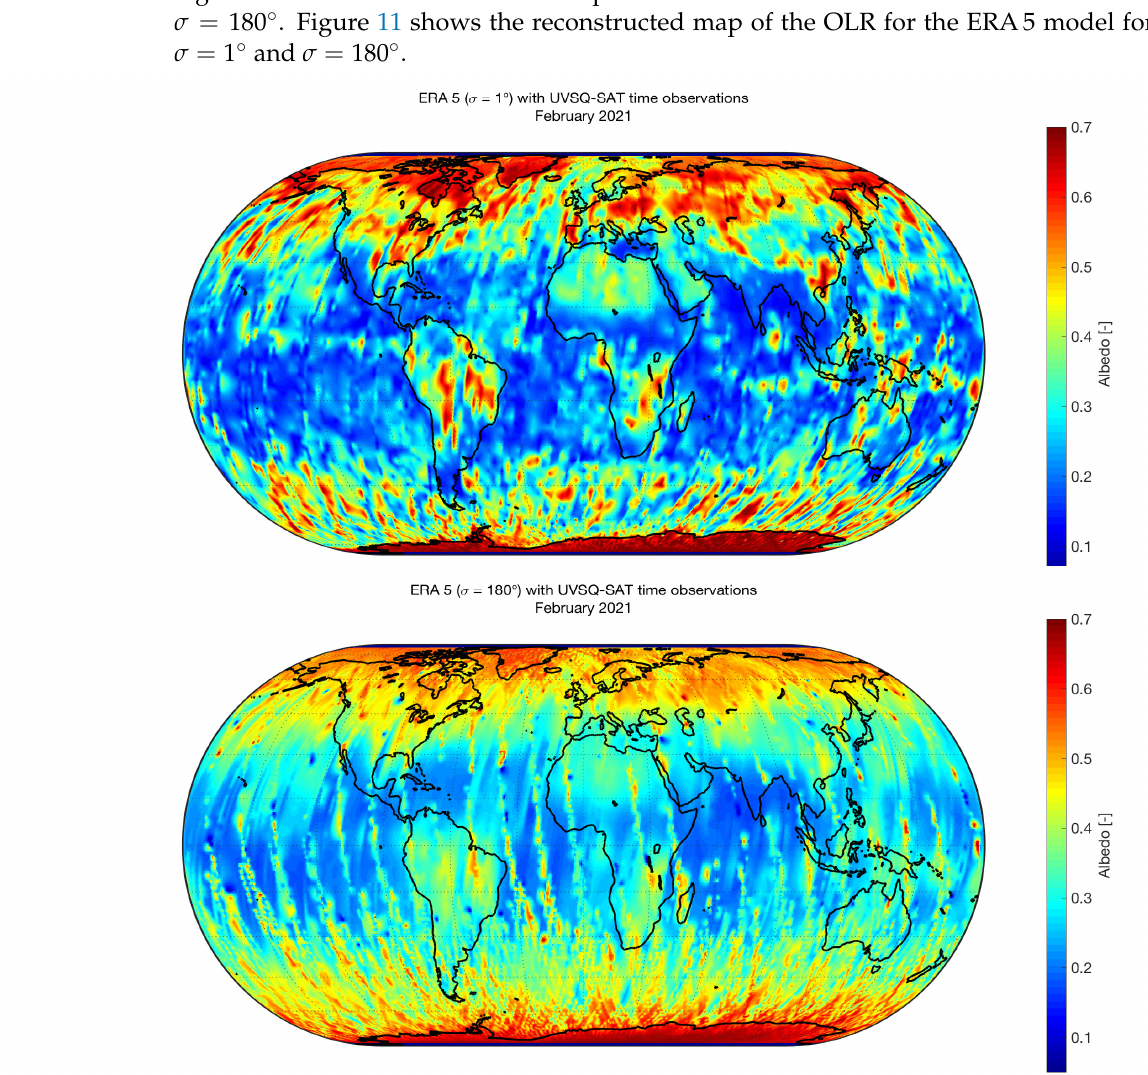
Figure 10. ( Top ) Albedo (ERA5) during the month of February 2021 from same observation than UVSQ-SAT ( σ = 1 ◦ ). ( Bottom ) Albedo (ERA5) from same observation than UVSQ-SAT ( σ = 180 ◦